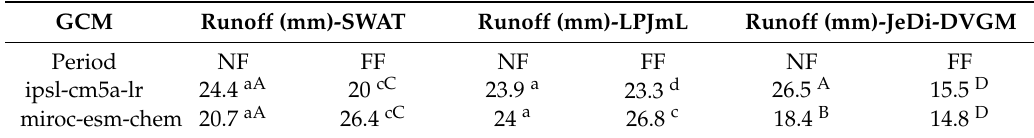
Table 6. Comparison of average monthly runoff predicted by the hydrological models